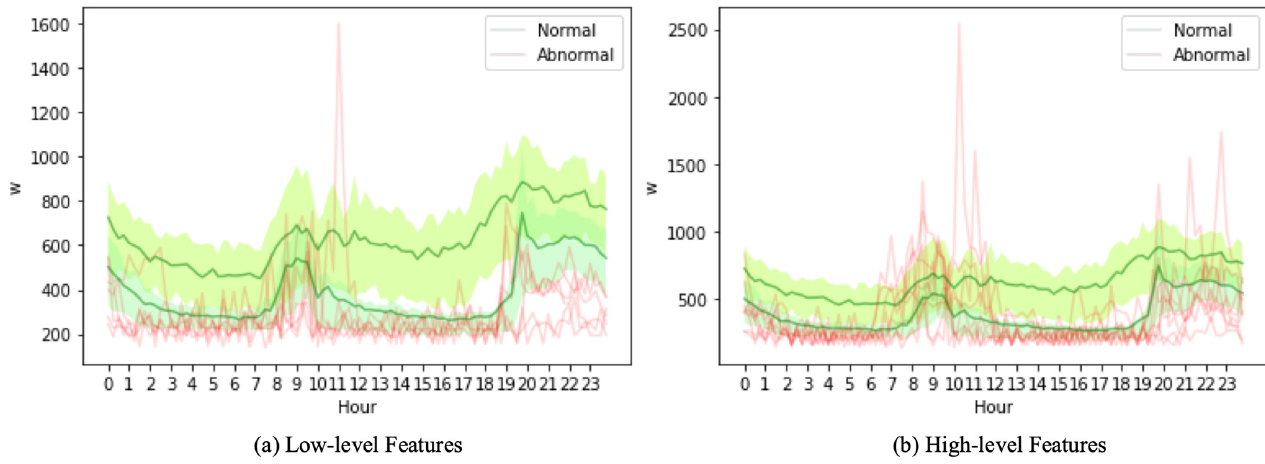
Figure 7. Load profiles of the main and abnormal electricity consumption events of User 03.